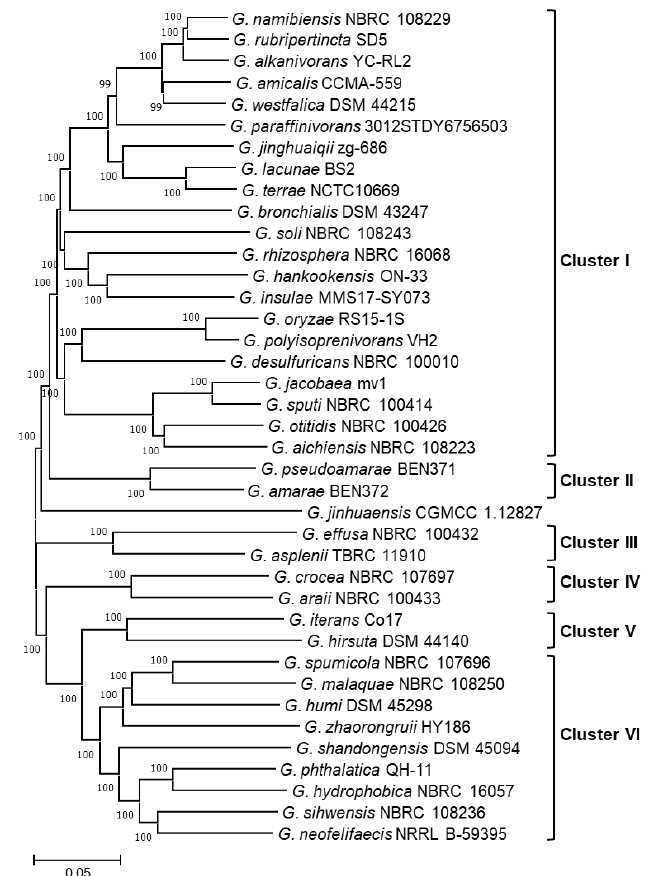
Figure 8. Phylogram of species of the genus Gordonia . The phylogenetic tree was inferred by maximum likelihood with FastTree 2 and drawn to scale, with branch lengths measured in the number of substitutions per site. The percentage of bootstrap that supported each node is shown. The analysis included 39 nucleotide sequences (from the 39 Gordonia species studied) and 693 markers (692,625 positions in total). Except for G. jinhuaensis , the species were grouped into seven clusters (i.e., I, II, III, IV, V, VI, and VII) using ClusterPickerGUI_1.2.3.